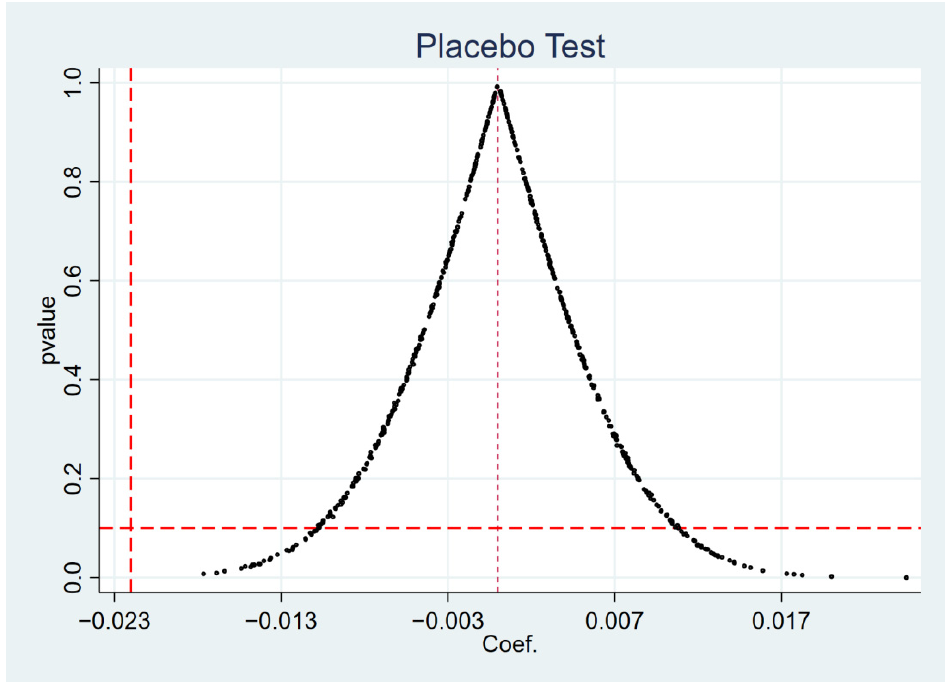
Figure 4. Placebo test for long-term debt financing.